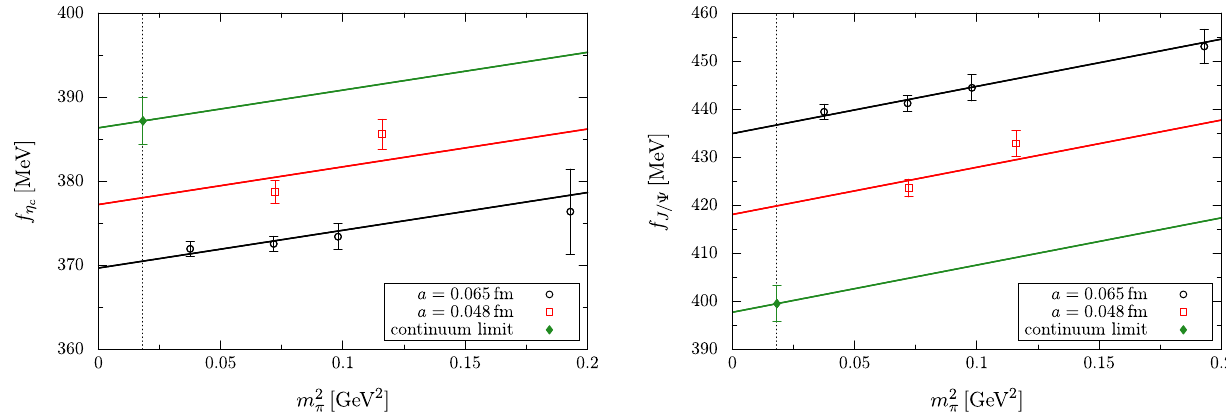
Fig. 6 Extrapolation at the physical point of f η Table 2 LO and NLO fit parameters and results for f η and f J /ψ , with their respective χ 2 per degrees of